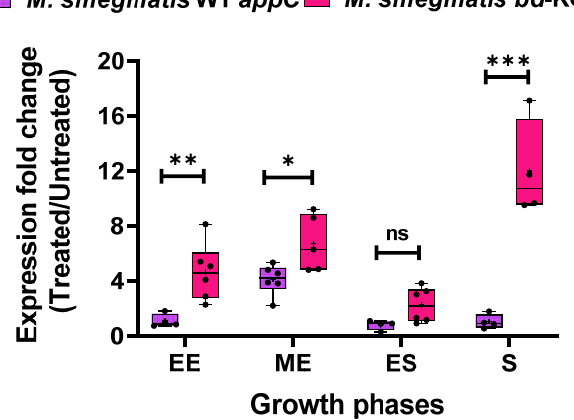
Figure 6. Expression analysis of the appC gene of Mycobacterium smegmatis WT and bd -KO in presence of Q203. Comparative analysis of fold change expression of appC gene in M. smegmatis WT versus bd -KO strain upon treatment with in Q203, as assessed by RT-qPCR (using 16S rRNA as normalising control). The evaluated growth phases were: early exponential phase (EE); mid-exponential phase (ME); early stationary phase (ES); and stationary phase (S). At least three biological replicates were performed. Each dot represents a biological replicate consisting of two technical replicates. p values was calculated with unpaired t -test for M. smegmatis WT versus bd -KO. * represents p -value ≤ 0.05; **, p -value ≤ 0.01; *** p ≤ 0.001; ns,